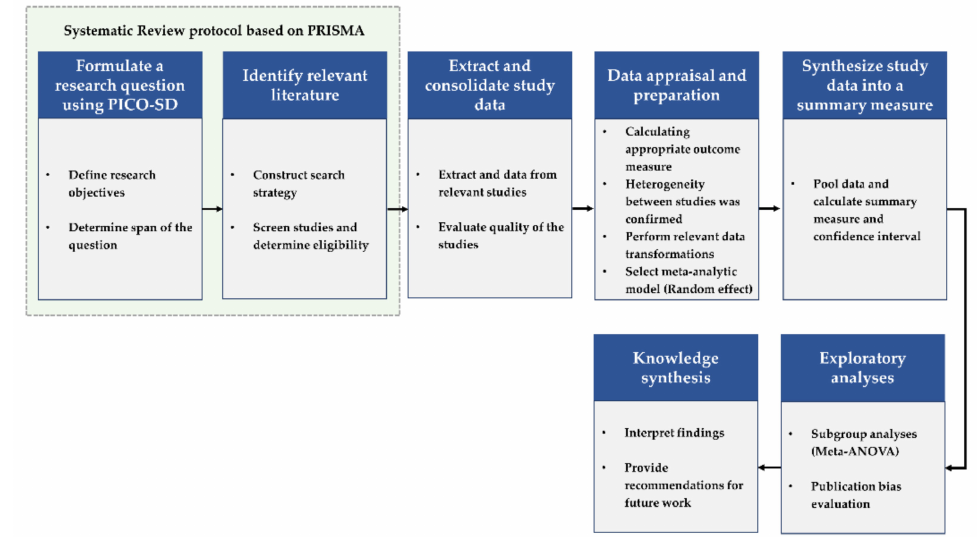
Figure 1. Systematic Review and Meta-analysis process diagram (Adapted from ref.